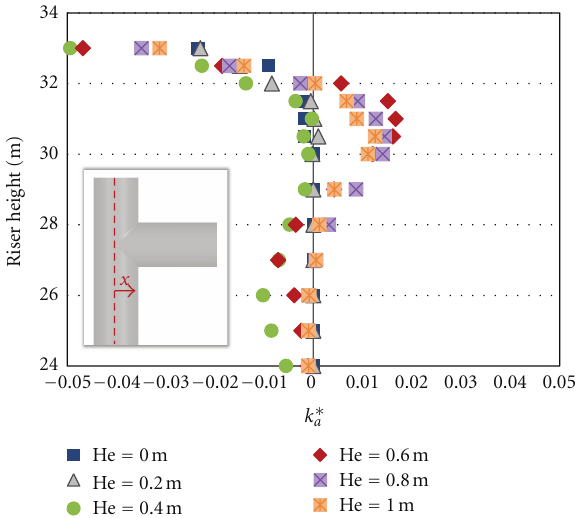
Figure 17: k ∗ parameter obtained along the height for di ff erent a projected heights.